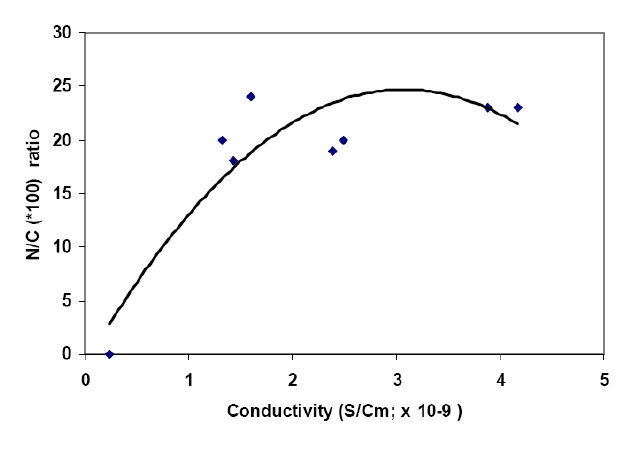
Fig. 5 Surface N/C atomic ratio effects on conductivity.